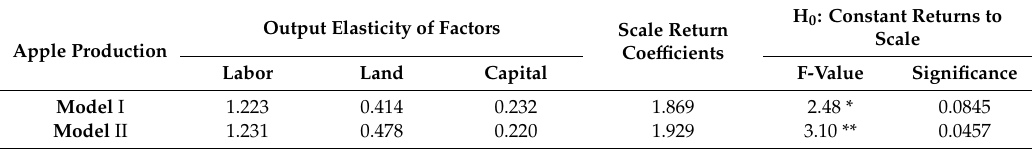
Table 4. Results of output elasticity and scale return coe ffi